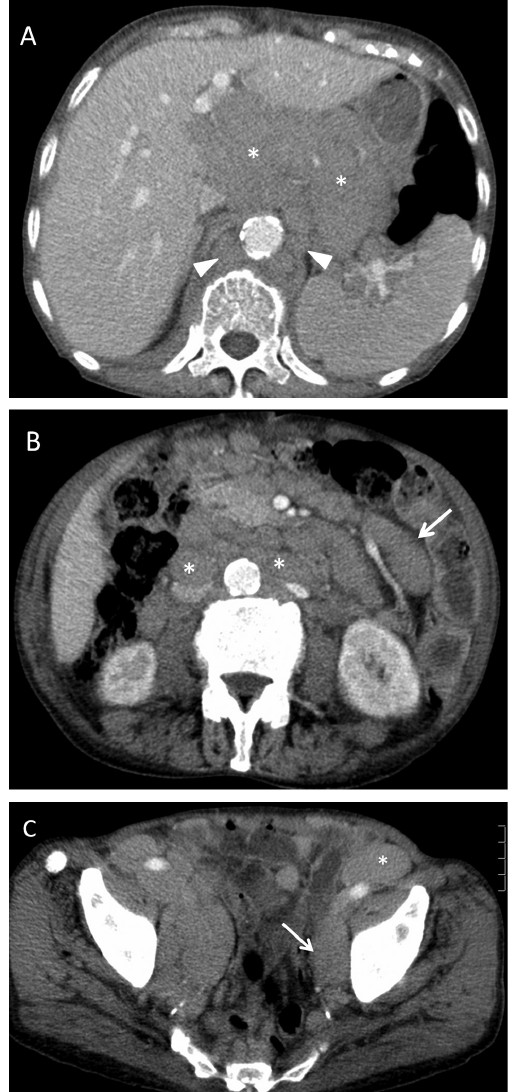
Figure 2 - An 84-year-old man with chronic lymphocytic leukemia. A: An enhanced CT image shows homogeneous enhancement of enlarged lymph nodes in the lesser omentum (star) and the upper para-aortic region (arrowhead). B: A contrast-enhanced image shows homogeneous enhancement of lymph nodes in the lower para-aortic region (star) and the mesentery (arrow). C: The enlarged lymph nodes show homo- geneous enhancement in the external iliac (arrow) and inguinal regions